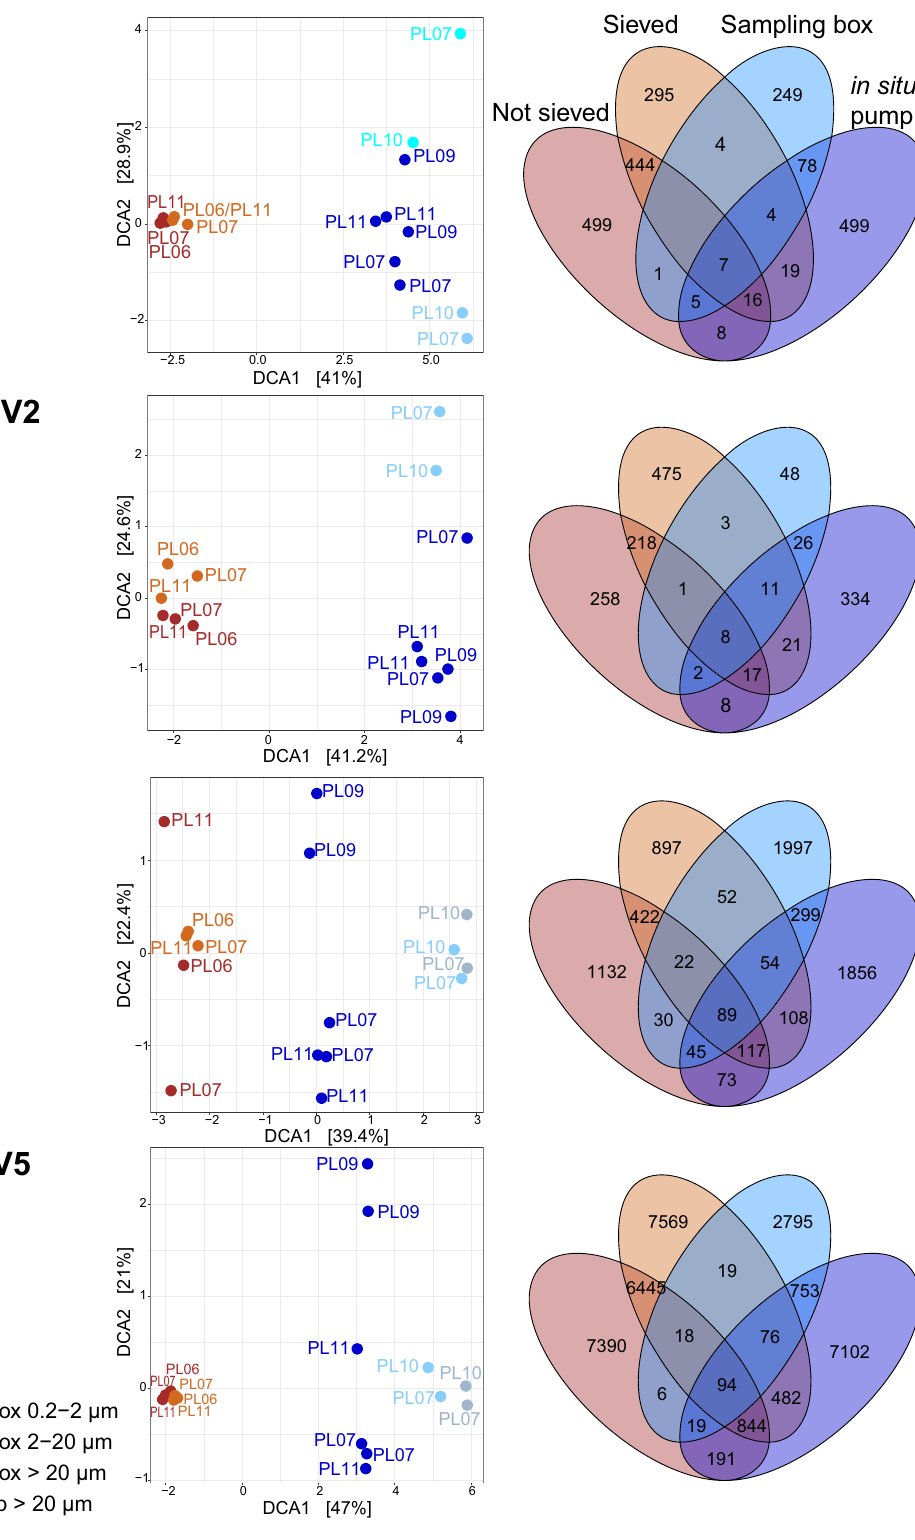
Figure 4. Detrended Correspondence Analyses (DCA) ordinations (left) and Venn diagrams (right), showing differences in community compositions detected by deep-sea sediment (brown) and aboveground water (blue) for metazoans (COI and 18S V1–V2), micro-eukaryotes (18S V4), and prokaryotes (16S V4–V5). Community segregation is strongest between sample types, but also among target size class in the water samples. Sediment was either sieved to size-sort organisms prior DNA extraction, or DNA was extracted directly from crude sediment samples. Water was collected with a 7.5 L sampling box, allowing recovery of two size classes in each taxonomic compartment, or sampled in large volumes with an in situ